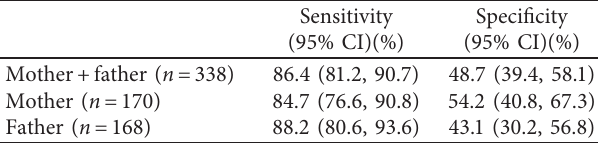
Table 5: Sensitivity and specificity for fever detection by palpation.